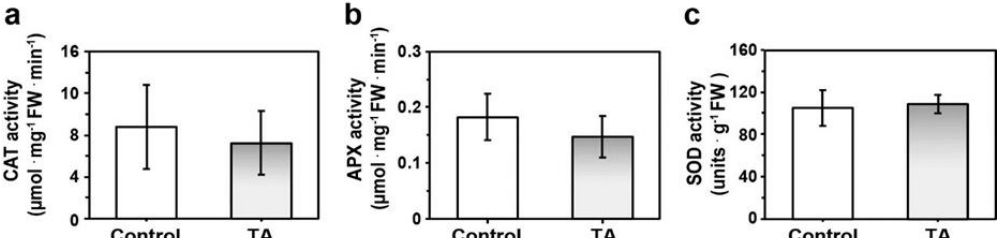
Figure 2. Antioxidant enzyme activity. Arabidopsis cell suspensions were treated with 0.1% methanol (Control) or 1 µM thaxtomin A (TA) for 24 h. ( a ) Catalase (CAT) activity in µmol ·mg −1 fresh weight (FW)·min −1 . Each value is the mean of two samples from three biological replicates ± SD ( n = 6). ( b ) Ascorbate peroxidase (APX) activity in µmol·mg −1 FW·min −1 . ( c ) Superoxide dismutase (SOD) activity in units·g −1 FW. ( b ) and ( c ) each value is the mean of three samples per condition ± SD. Data was analyzed using the t -test followed by the Holm-Šídák method with alpha = 0.05. No significant difference was detected ( p < 0.05).